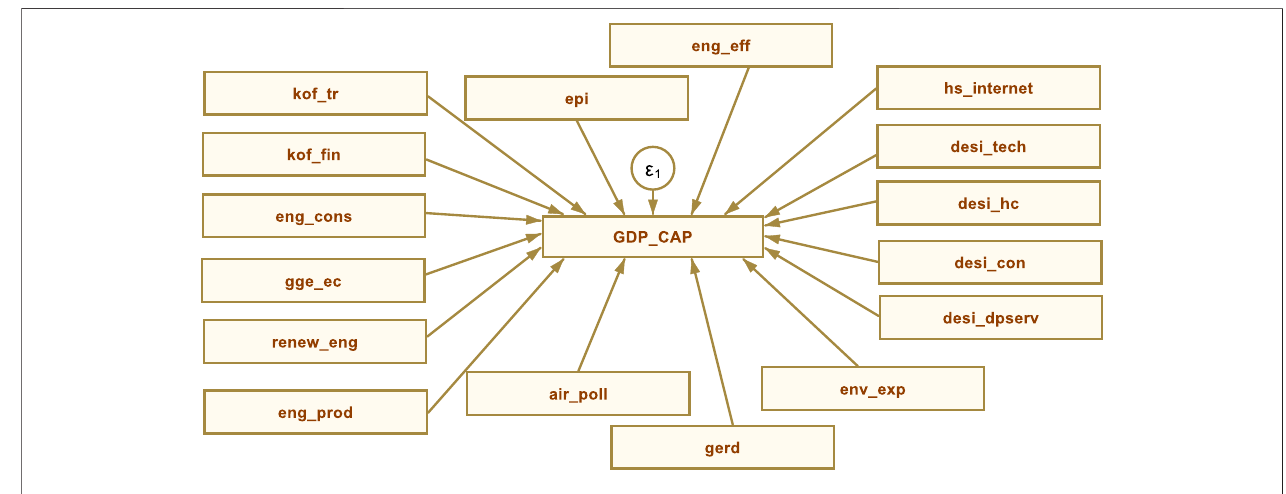
FIGURE 1 | | General con fi guration of the SEM model. Source: Authors ’ contribution.